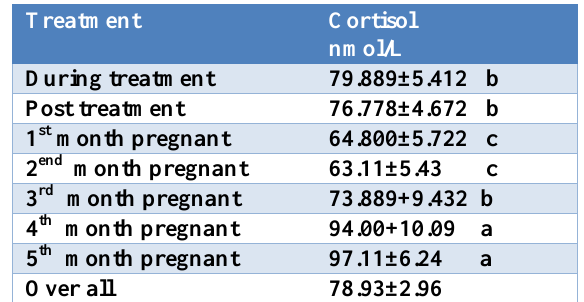
Table, 2: Serum cortisol profiles and their temporal interrelationship –during progesterone treatment, induce estrous ,laproscopical insemination and pregnancy in Iraqi